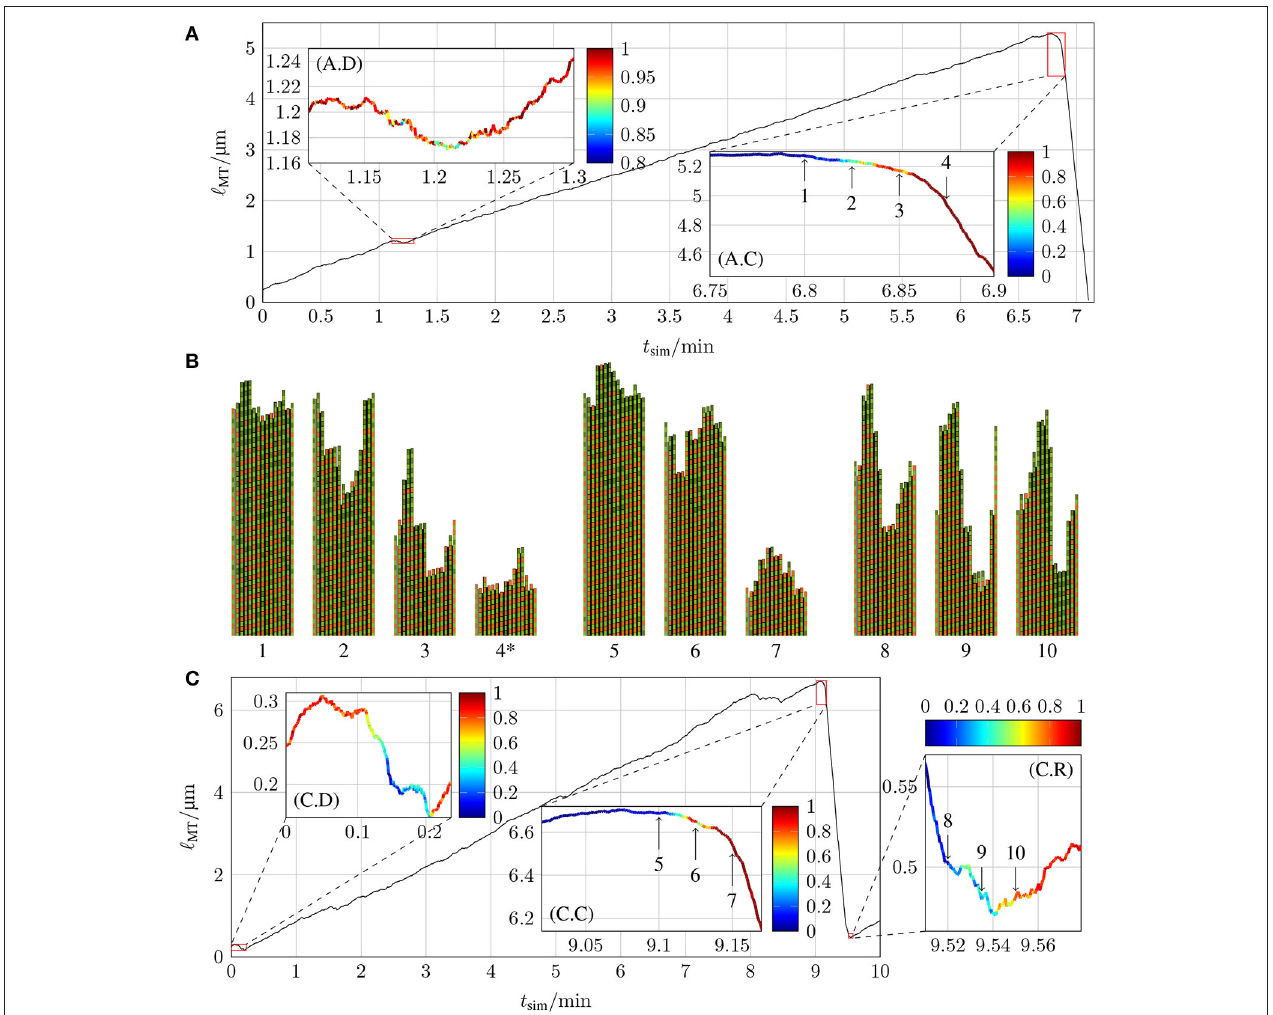
FIGURE 10 | Lengths of two MTs as a function of simulation time t sim with k + = 4 µ M − 1 s − 1 , 1 G 0 ∗ long = − 9.3 k B T , k lat = 100 k B T / nm 2 , and (A) c tub = 8 µ M and k hydr = 0.1s − 1 and (C) c tub = 9 µ M and k hydr = 0.2s − 1 . The insets highlight parts of the trajectories of interest for the dynamics and color-code the probability of the ℓ